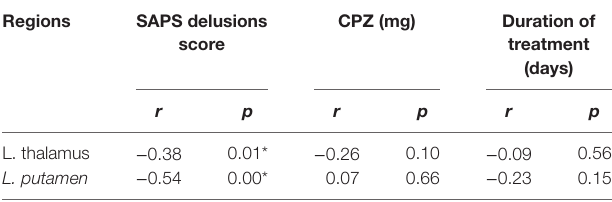
TaBle 3 | Spearman’s correlation coefficients between the regional gray matter volume and clinical measures in the first-episode schizophrenia ( n = 42). regions saPs delusions cPZ (mg) score